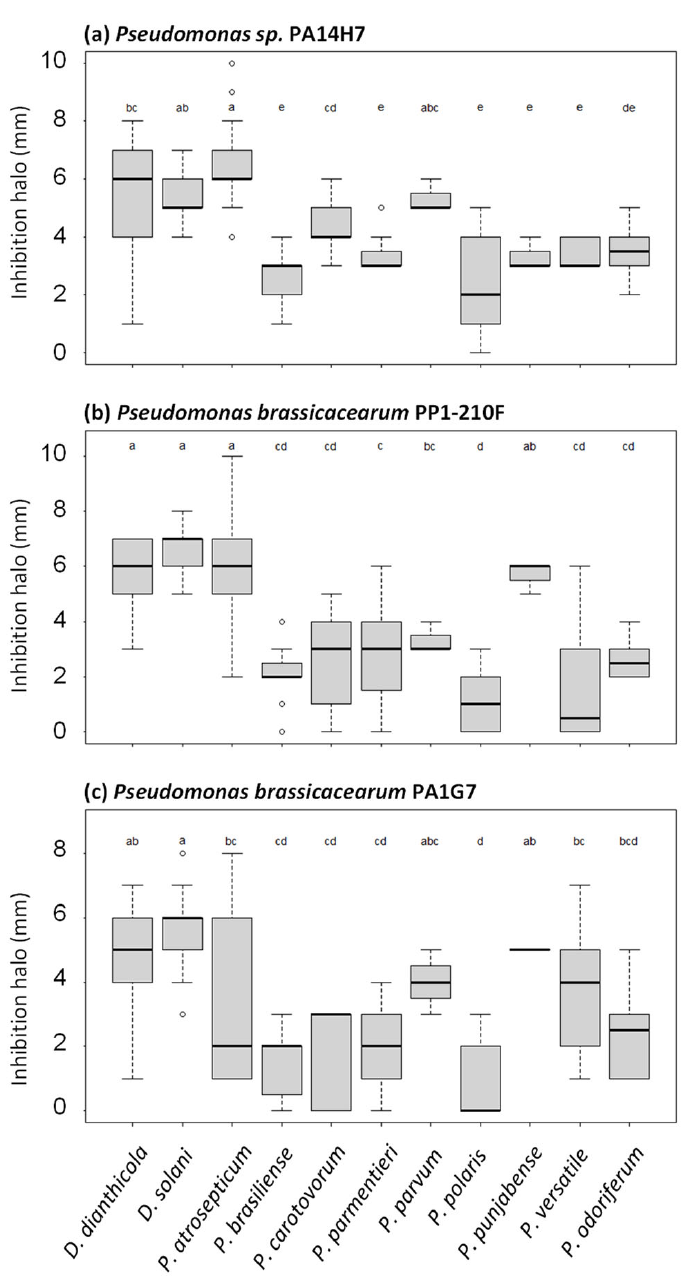
Figure 4. Refined analysis of growth inhibition halos caused by Pseudomonas sp. PA14H7 ( a ) and P. brassicacearum PP1-210F ( b ) and PA1G7 ( c ). The same data shown in Figure 3 were analyzed in a different way. For each biocontrol agent, we calculated mean value and variation for all halos collected with pathogen isolates belonging to the same species. Statistical differences (Kruskal–Wallis test multiple comparison (Dunn), p -value adjusted with the Benjamini–Hochberg method, alpha = 0.05) are indicated by different letters (a to e); horizontal bar indicates mean value.